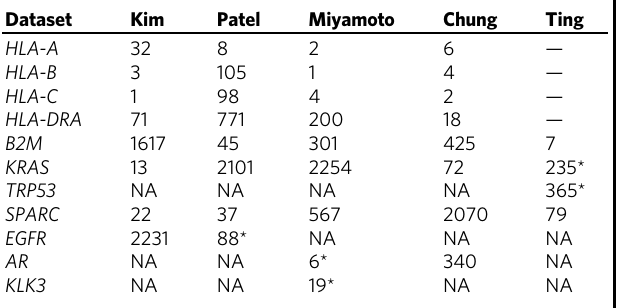
Table 2 A list of interested genes highly ranked